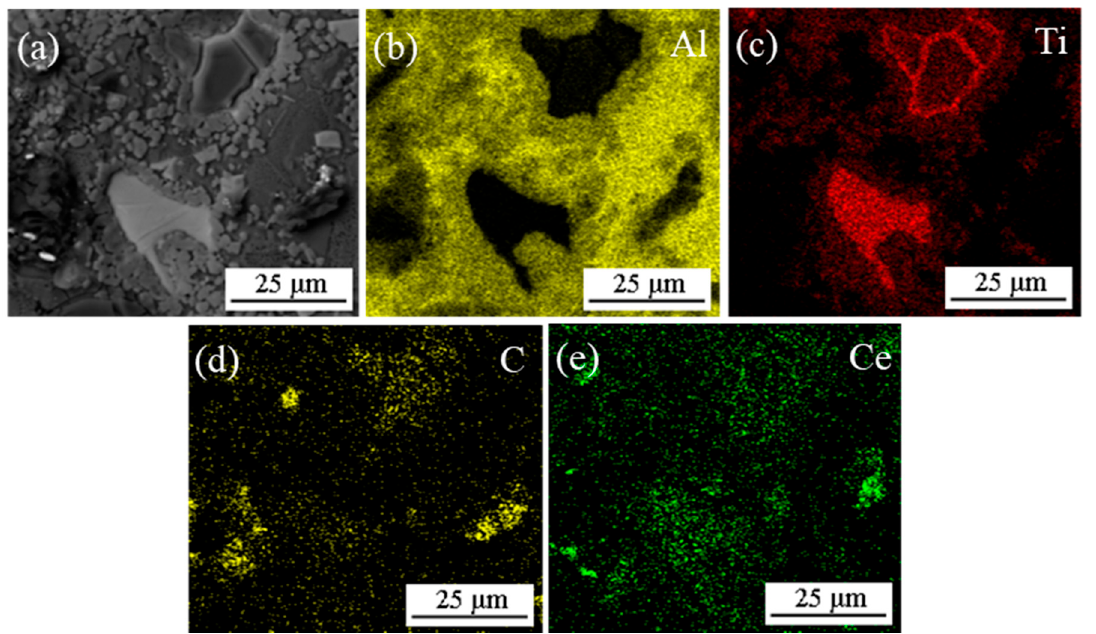
Figure 10. The map scan patterns of Figure 9d: ( a ) backscattered electron image of Figure 9d; ( b – e ) map scanning patterns of Al, Ti, C and Ce elements, respectively.